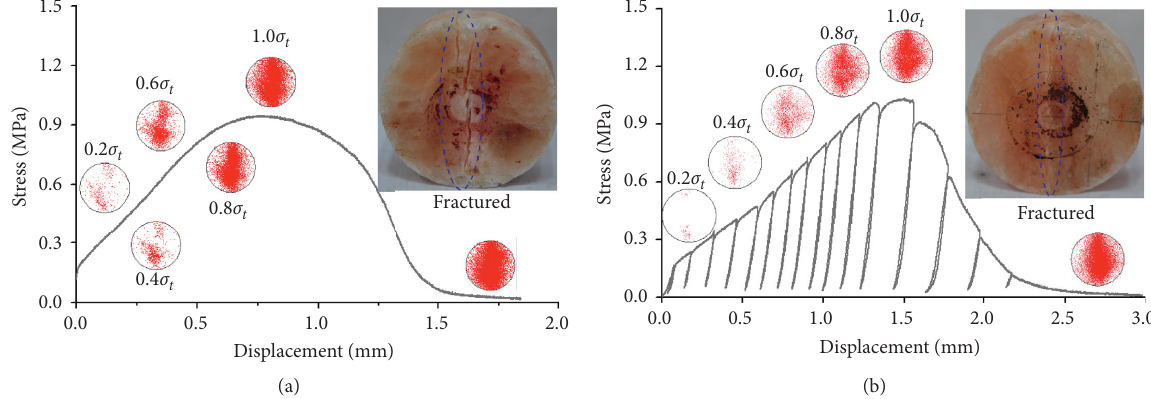
Figure 5: Spatiotemporal map of AE events of different stages and fractured salt rock specimens. (a) d-1; (b)